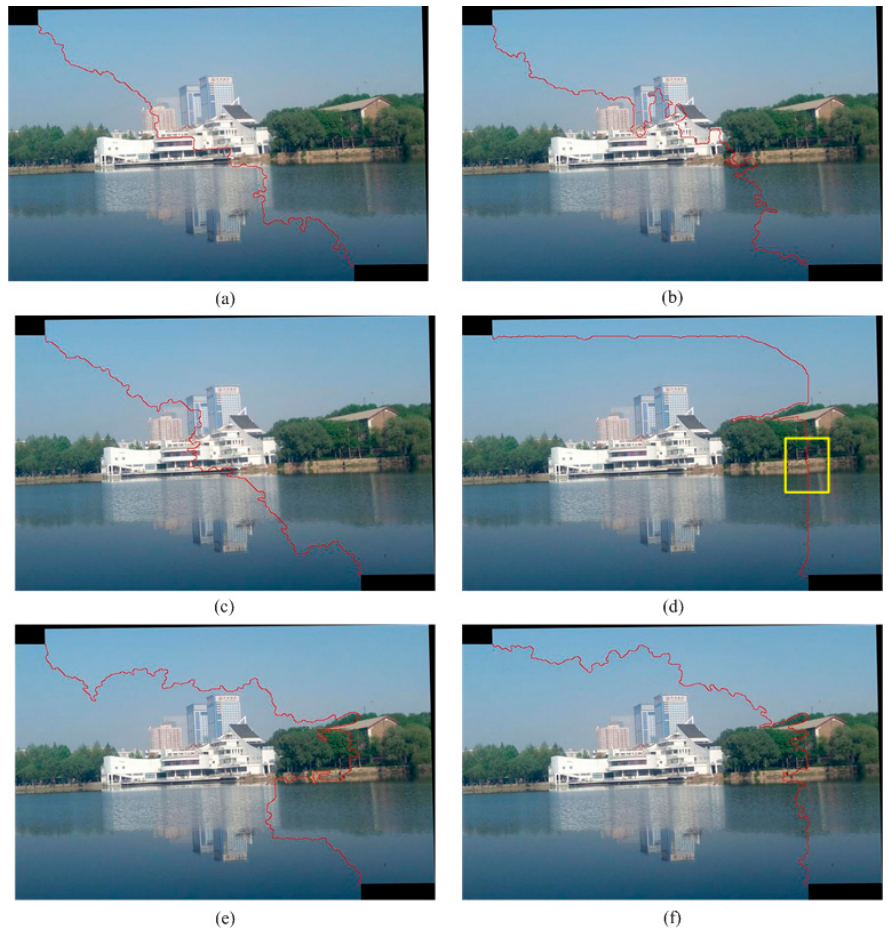
Figure 5. The stitch line results with different weight map: ( a ) VN, ( b ) LD, ( c ) VM, ( d ) VS, ( e ) WM with parameter set 0.1, 0.2, 0.2, 0.5, and ( f ) 0.1, 0.1, 0.25, 0.55. Table 4. Evaluations of fusion effects in Figure 6.